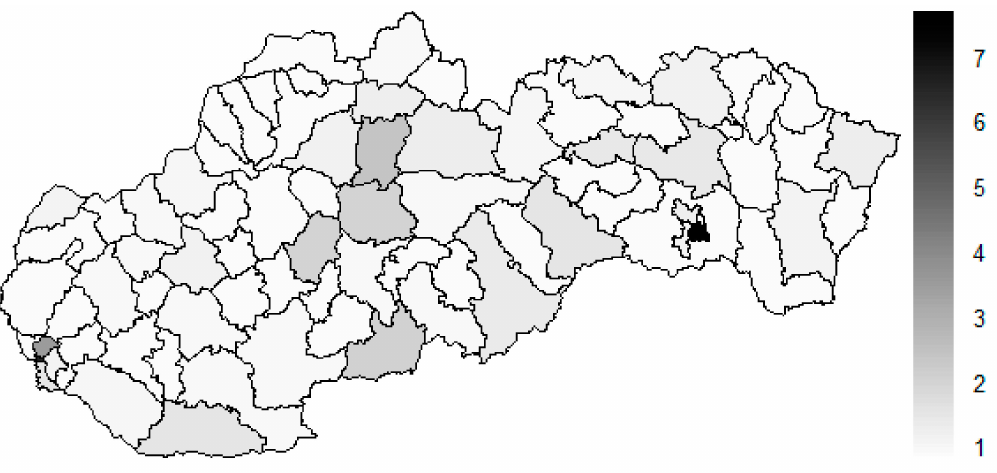
Figure 7. Medical equipment similarity map of the districts in the year 2008. Source: own elaboration by the